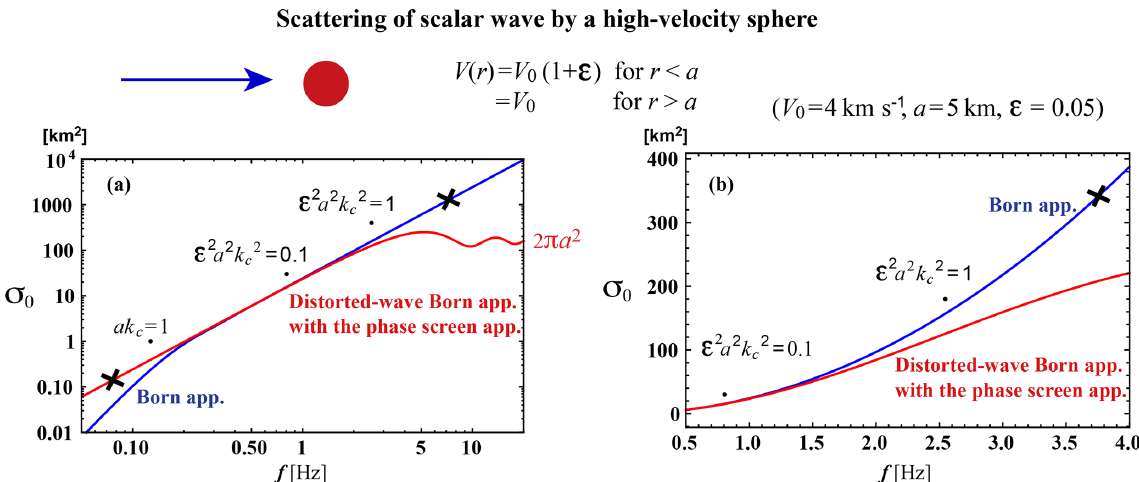
Figure 6. Deterministic scattering of scalar waves by a high-velocity sphere. (a) Log–log plot of the total scattering cross section against frequency. (b) Semi-log plot for zoomed in graph. The Born approximation and the distorted-wave Born approximation with the phase screen approximation are drawn by blue and red lines,